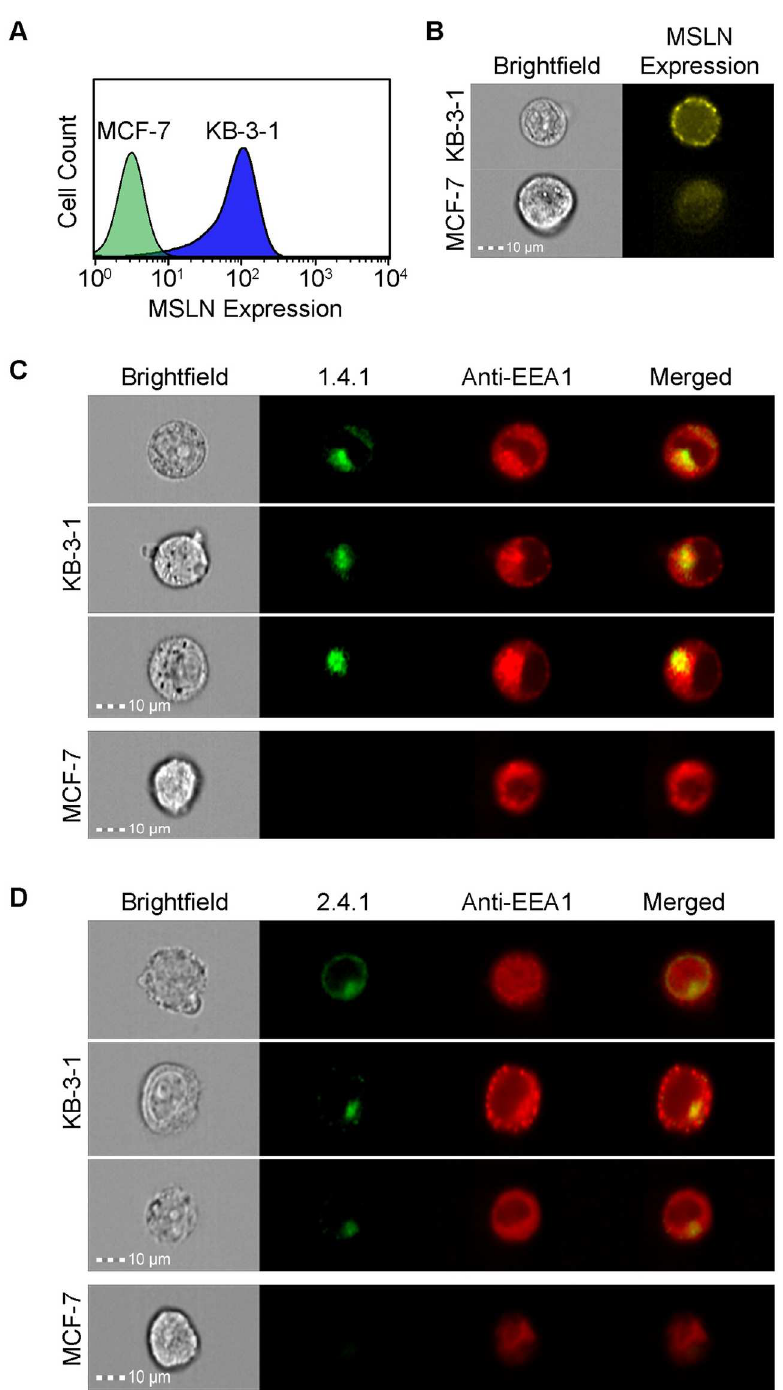
Fig 6. Engineered Fn3 protein variants 1.4.1 and 2.4.1 localized to early endosomes upon binding MSLN. Analysis by (A) flow cytometry and (B) imaging flow cytometry confirms MSLN presence on the surface of KB-3-1 cells compared to the MSLN-negative MCF-7 cells, as detected by an anti-MSLN antibody. (C, D) KB-3-1 cells ( top ) internalize AF488-labeled 1.4.1 (C) and AF488-labeled 2.4.1 (D), while MCF-7 cells show no specific binding or internalization (C bottom , D bottom ). Endosomes are detected by an AF647-conjuated antibody recognizing the EAA1 early endosomal marker. Yellow in the merged images indicate co-localization between AF488-1.4.1 or AF488-2.4.1 anti-MSLN engineered proteins (green) and EEA1 (red). Original magnification 40X. Co-localization is quantified by the Bright Detail Similarity (BDS) metric, with values near 1 indicating co-localization. KB-3-1 BDS = 1.31 and